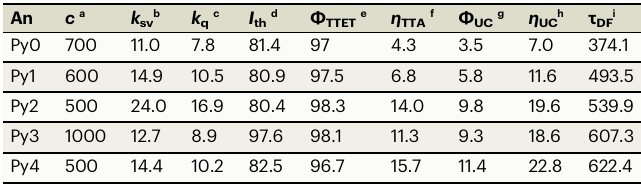
Table 2 | TTA-UC characteristics of annihilators (Py0-Py4) in combination with PdTPBP in